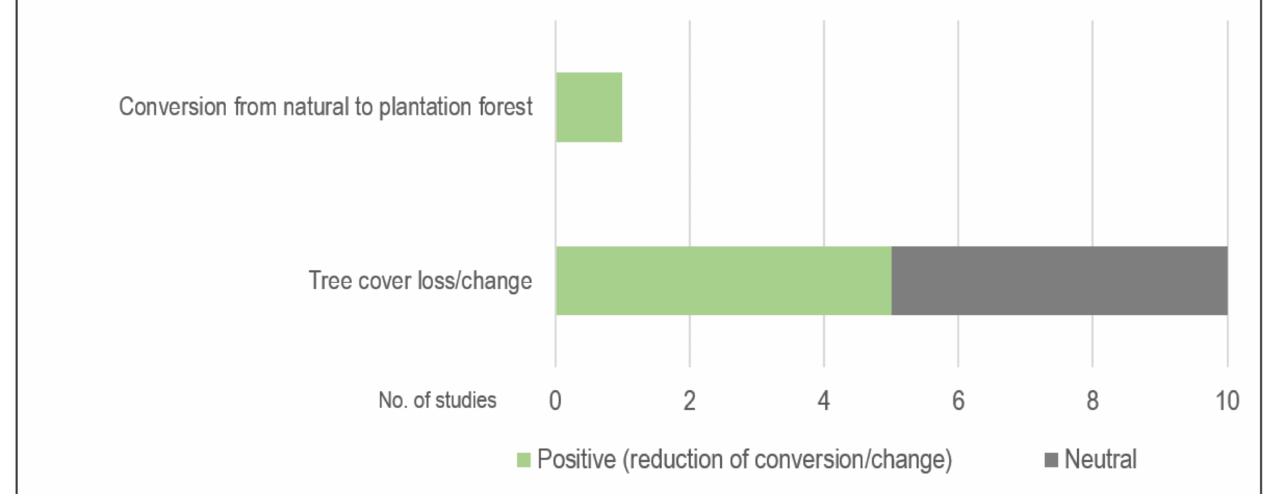
Figure 3. Impact of forest certification on deforestation. Presented by indicator and number of case studies.